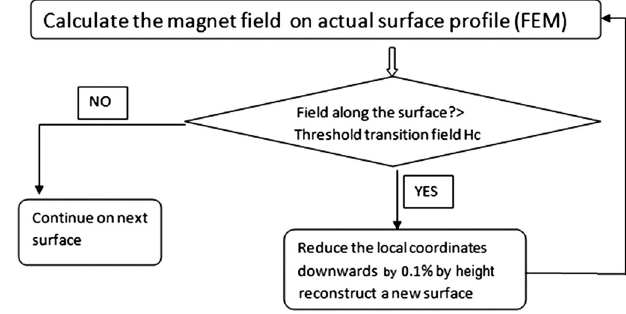
FIG. 4. The LGMFE map is calculated from the profile in Fig. 2. These indexes do not change with the applied field. Unit: μ